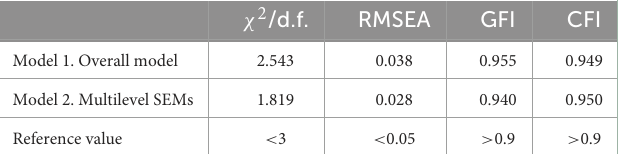
TABLE 3 Goodness-of-fit statistics of the model and reference value. χ 2